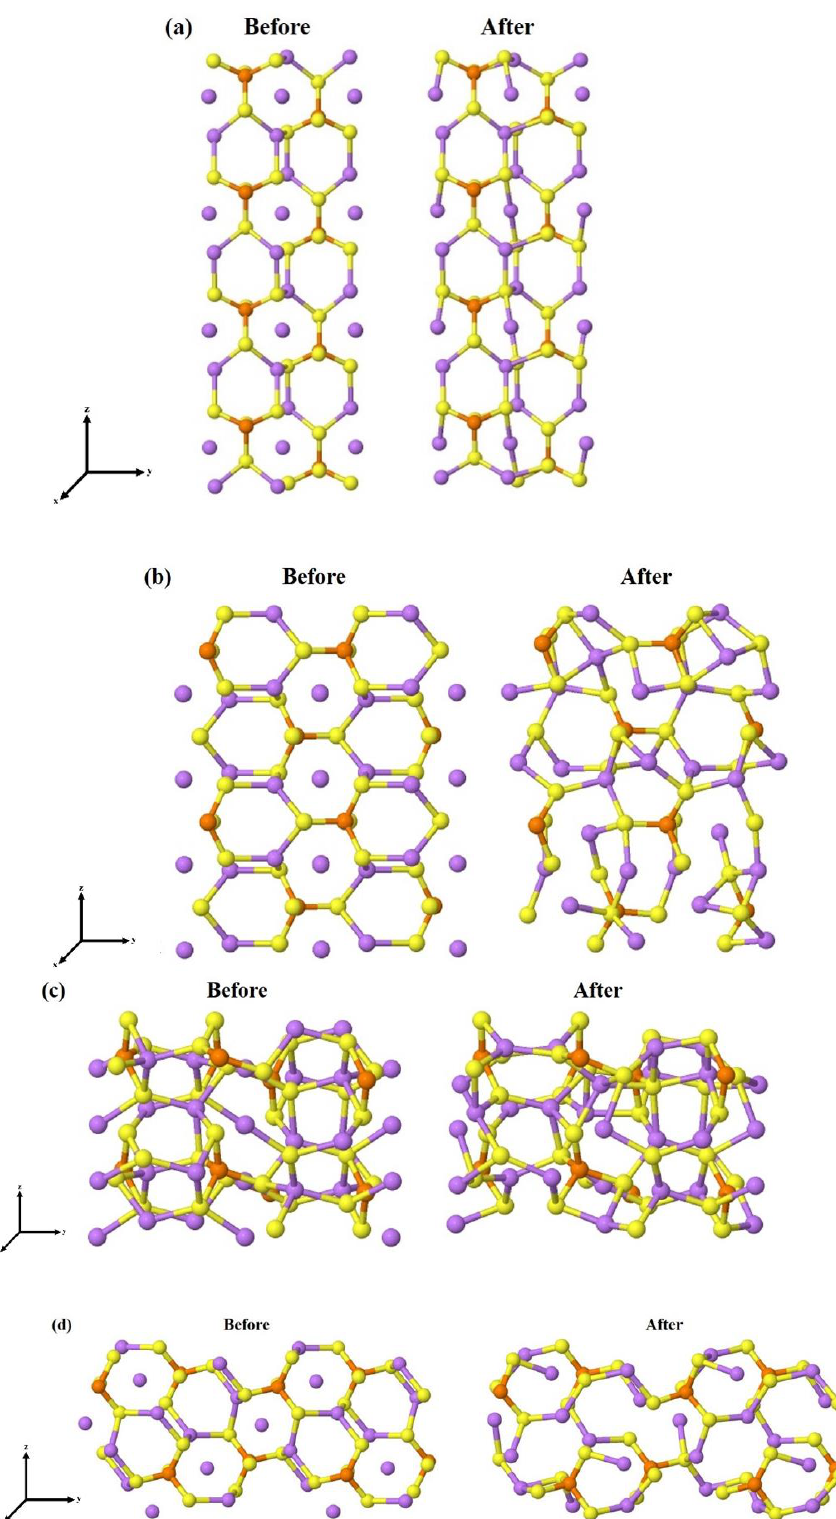
Figure 3. Stable surfaces cut from bulk, before and after geometry optimization ( a ) (100), ( b ) (010), ( c ) (011), and ( d ) (210). The spheres in purple, orange, yellow, and black are related to the lithium, phosphor, and sulfur atoms, respectively. Table 3. Surfaces ’ termination (up/down), surface energy ( E surf , in J/m²), formation energy ( E form , in kJ/mol), and band gap ( E gap , in eV) for the nine surfaces of β -Li 3 PS 4 with eight units each.